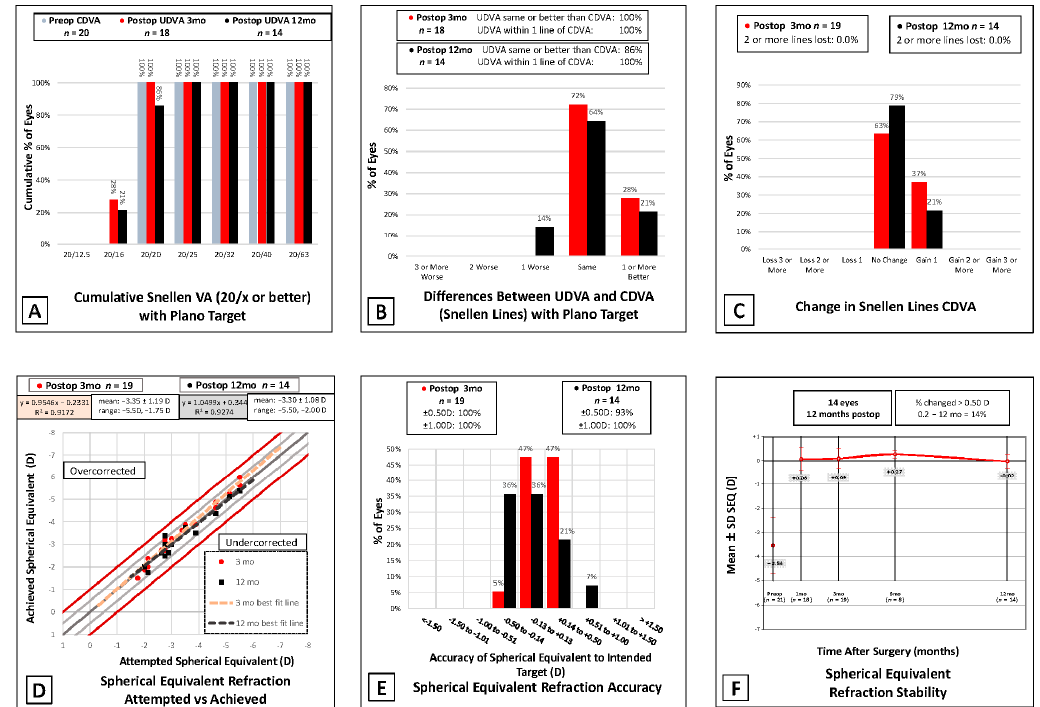
Figure 2. Six standard graphs for reporting corneal refractive surgical outcomes. ( A ) Postoperative uncorrected distance visual acuity versus preoperative corrected distance visual acuity. ( B ) Differ- ences between uncorrected distance visual acuity and corrected distance visual acuity postopera- tively. ( C ) Change in corrected distance visual acuity preoperatively versus postoperatively. ( D ) Spherical equivalent refraction attempted versus achieved. ( E ) Postoperative spherical equivalent refraction accuracy. ( F ) Stability of spherical equivalent refraction over time. Preop: preoperative; postop: postoperative; SEQ: spherical equivalent refraction.